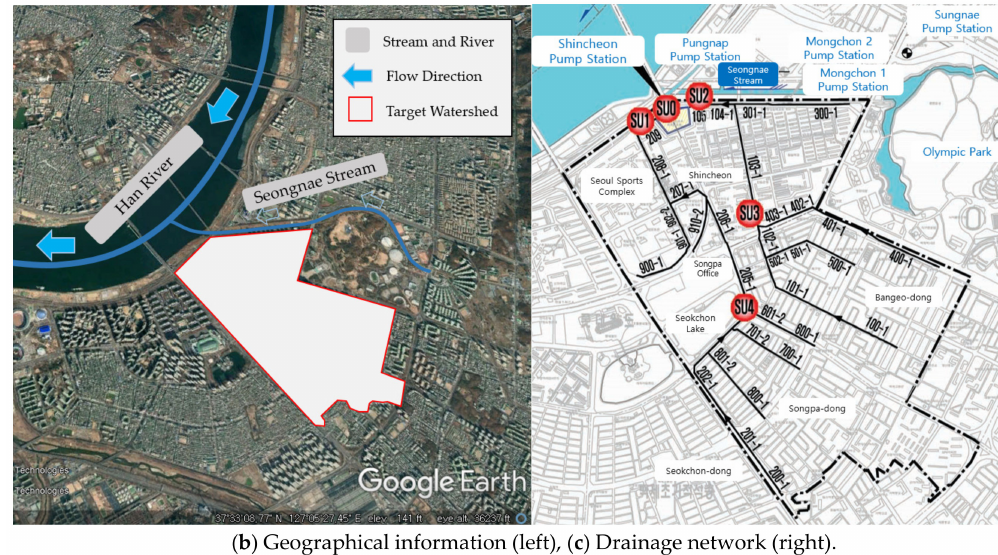
Figure 5. Geographical information and drainage network of Shincheon area.